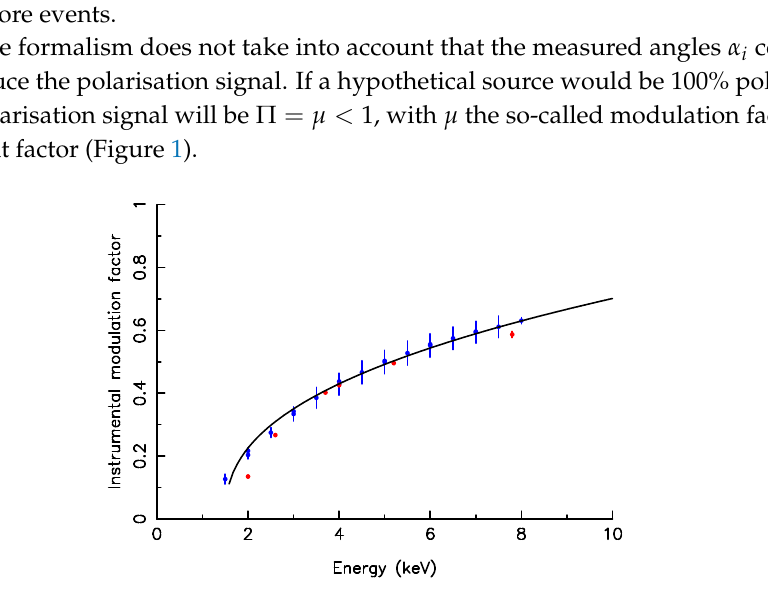
Figure 1. The modulation factor, µ , as a function of energy, i.e., the measured polarisation fractions for a 100% polarised source, not correcting for instrumental effects.The red points are measurements taken from Muleri et al. [15]. The blue points are based on the Monte Carlo code described in this √ E for the photo-electron ejection angle. The curved line is an text, and uses a Gaussian error ∆ α ∝ analytical approximation for the modulation factor, used for the corrections on a event-by-event